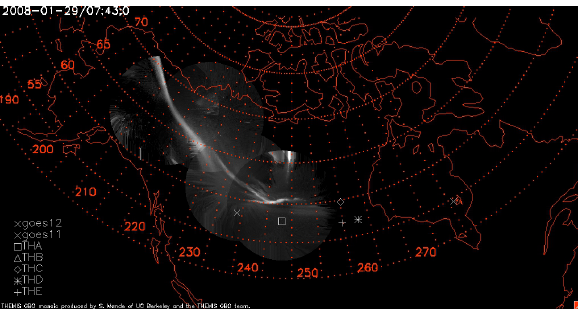
Figure 20. The January 29 th 2008 ~07:41 event showing the auroal brightening at the Fig. 20. The 29 January 2008 ∼ 07:41 event showing the auroal start of the poleward expansion (SPE) and the position of the magnetic foot prints of the THEMIS and GOES satellites. brightening at the start of the poleward expansion (SPE) and the po- sition of the magnetic foot prints of the THEMIS and GOES satel- Discussion.